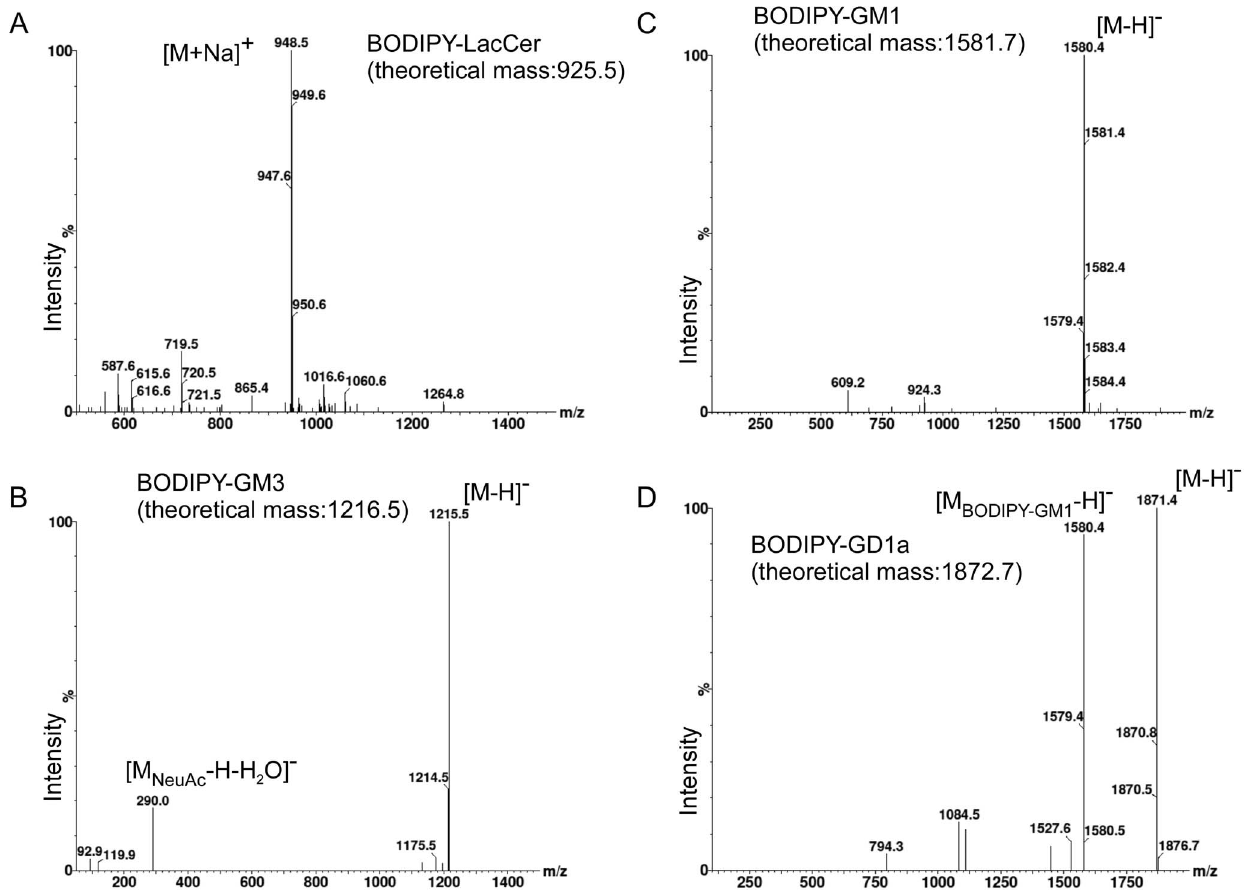
Figure 6. QTof MS and MS/MS analysis of the BODIPY labelled substrates and products in SAT I and SAT IV catalysed reactions. (A) MS spectra of BODIPY-LacCer in positive mode; (B) MS/MS spectra of BODIPY-GM3 in negative mode; (C) MS spectra of BODIPY-GM1 in negative mode; (D) MS/MS spectra of BODIPY-GD1a in negative mode.